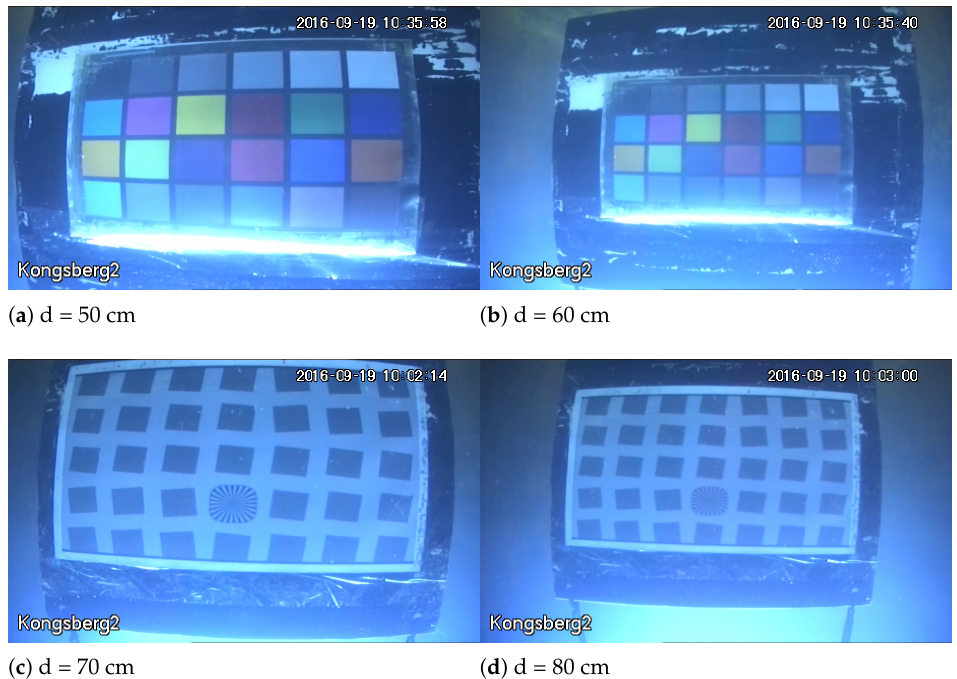
Figure 4. The transparency of the water body is 325 cm, which is part of the images under natural